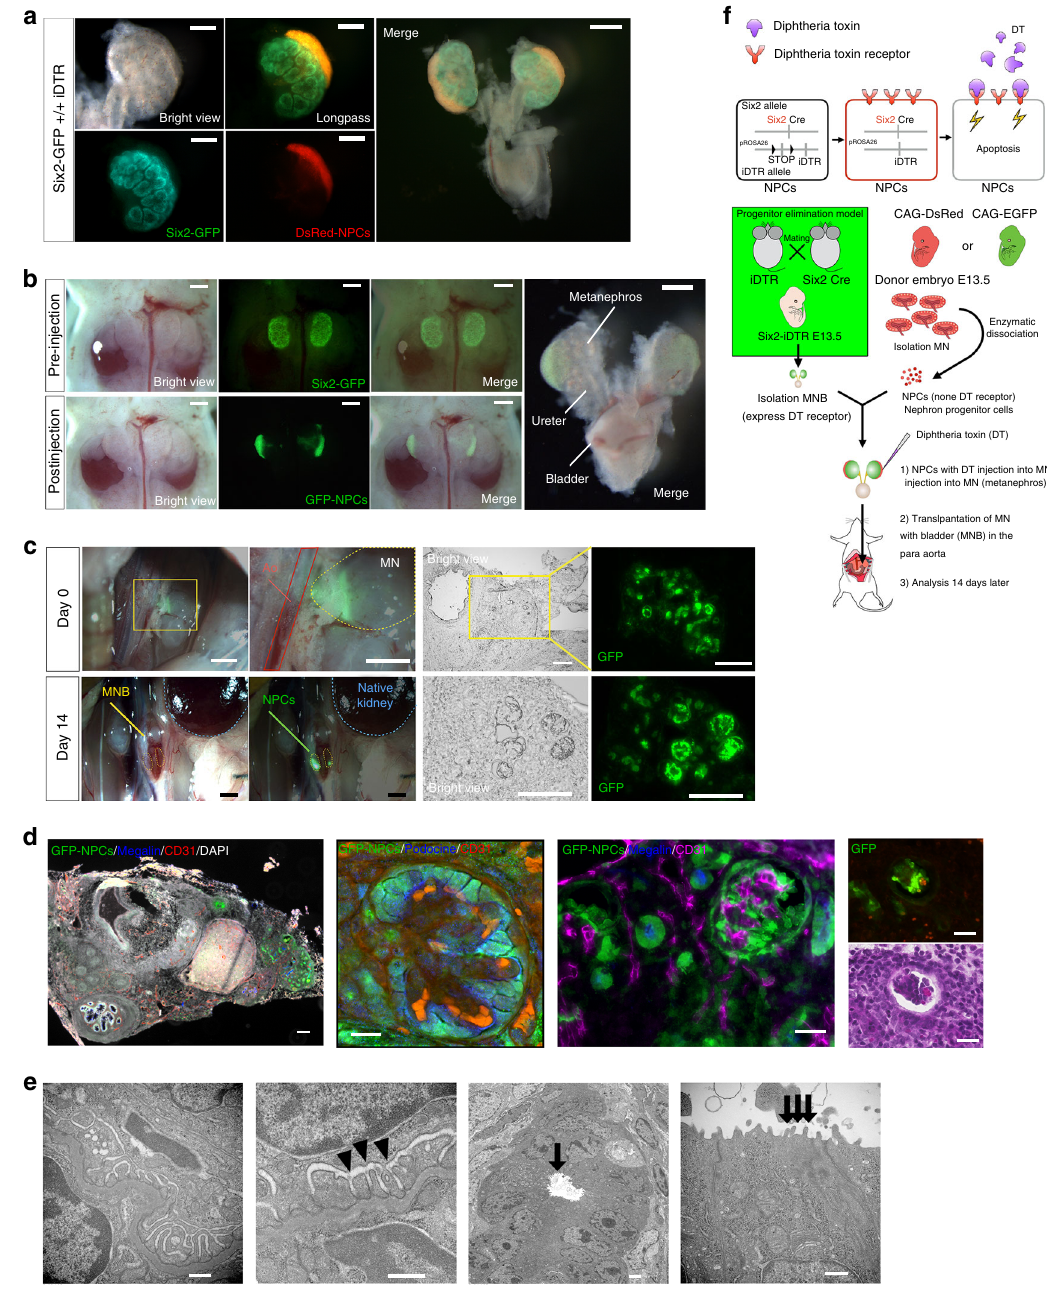
Fig. 7 Regeneration of the nephron derived from the transplanted cells in vivo and presence of blood vessels in the neoglomerulus. a Diphtheria toxin (DT) and nephron progenitor cells (NPCs) were administered under the renal capsule in the cap mesenchyme (CM) of the progenitor ablation model. NPCs showed strong green fl uorescent protein (GFP) expression (CAG promoter); therefore, we were unable to observe the NPCs under a fl uorescence stereoscopic microscope alongside Six2-GFP (native promoter) after transplanting (scale bar, left: 250 µ m, right: 500 µ m). b The progenitor elimination model into which DT and DsRed-NPCs were transplanted. c We transplanted the MN into the vicinity of the aorta in an adult mouse. GFP NPCs and DT were administered under the renal capsule, and GFP expression was evaluated 14 days later (scale bar, left and second from left: 1 mm, right and second from right: 100 µ m). d From the collected MN, frozen sections were created and analyzed by immunostaining. All of the cells originating in the NPCs were GFP positive. Megalin is a tubular marker, and CD31 is an endothelial marker (scale bar, left column: 100 µ m, second from left: 25 µ m, second from right: 10 µ m). Fourteen days after transplanting, we observed glomeruli originating from transplanted cells within the CM and podocin-positive epithelial cells lining the endothelial cells (second from left). The glomeruli had vascularized in part through blood vessels originating from the host (second from right) and contained red blood cells (right column: 50 µ m). e Aligned podocytes and glomerular basement membrane in neoglomerulus were observed by transmission electron microscopy (left column, second from left). Slit diaphragm structures were observed (second from left arrowheads). Neo-tubules showed brush borders (second from right, right column arrows). Scale bars: left column, 500 nm; second from left, 500 nm; second from right, 2 µ m; right column, 500 nm. f Schematic of the experimental